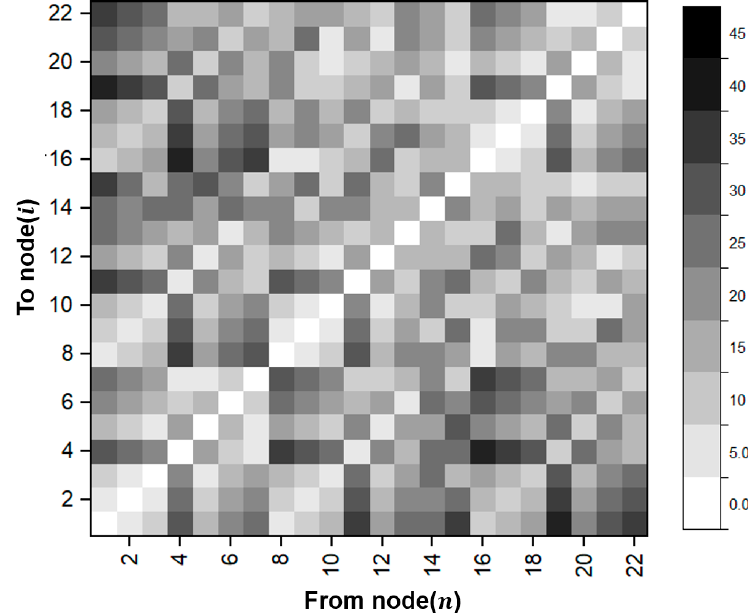
Figure 8. Arc modeling in RBTS 2 Bus.